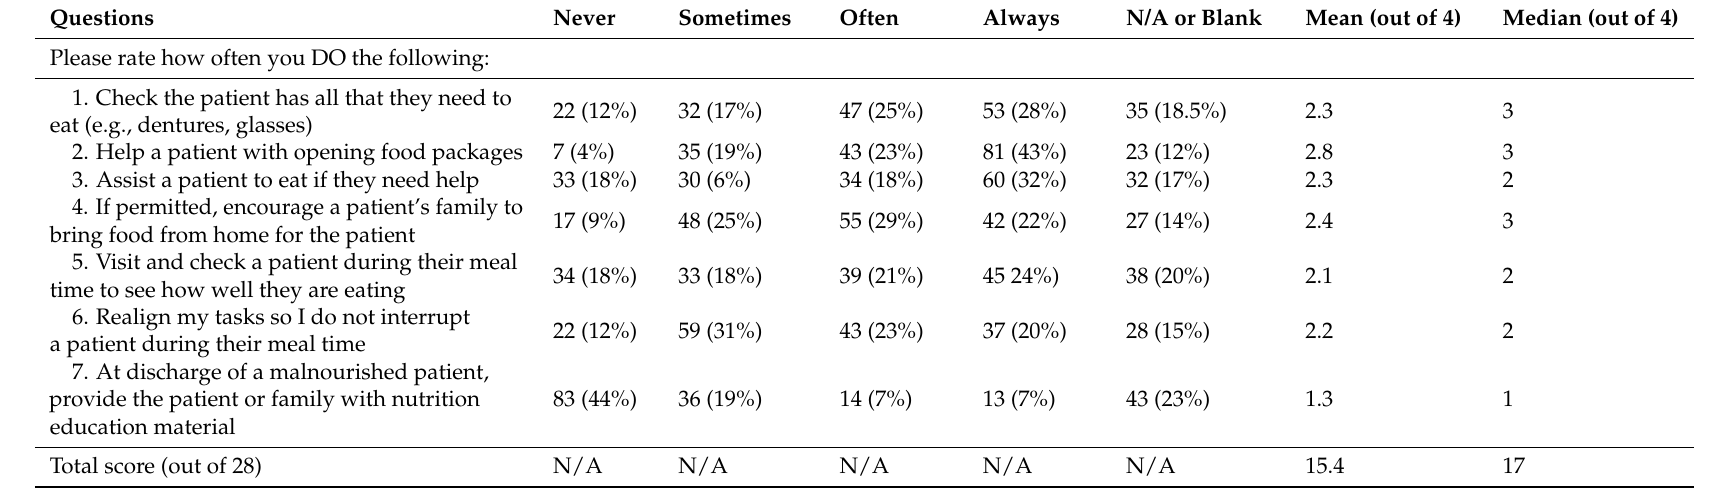
Table 5. Study 2: Proportion of responses for practice questions (N =